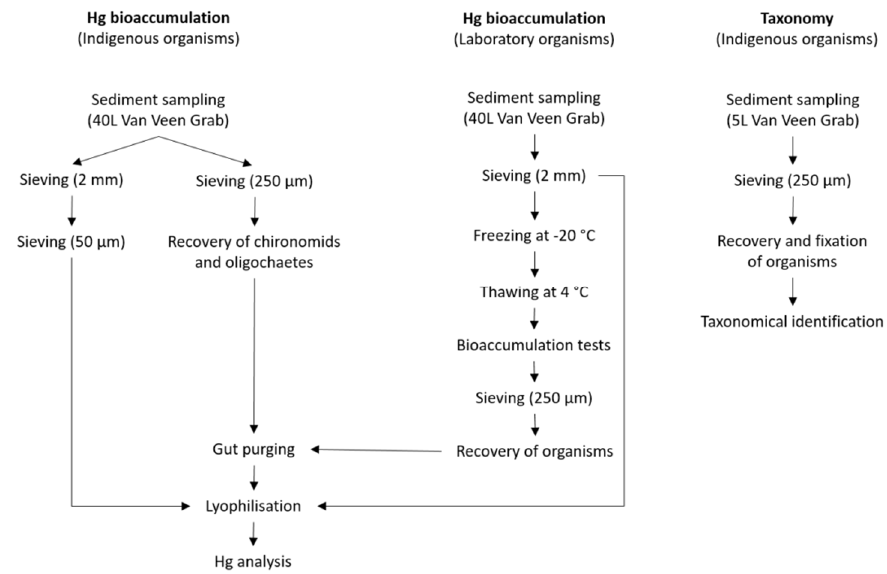
Figure 2. Overview of treatment procedures undergone by sediments sampled for di ff erent purposes in the course of the present study.